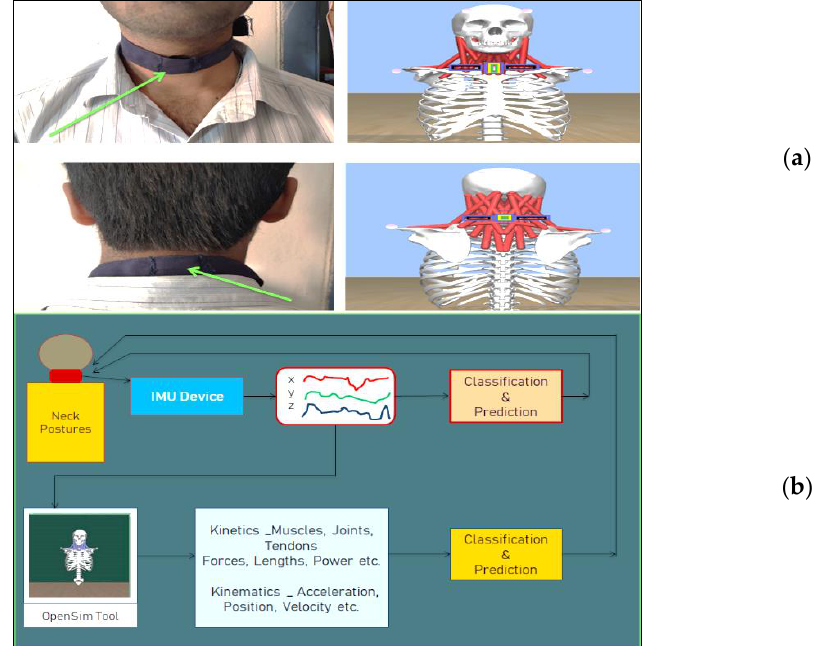
Figure 5. ( a ) IMU locations and corresponding musculoskeletal model; ( b ) IMU to OpenSim — data flow. Table 2. Dataset quantitative parameters.